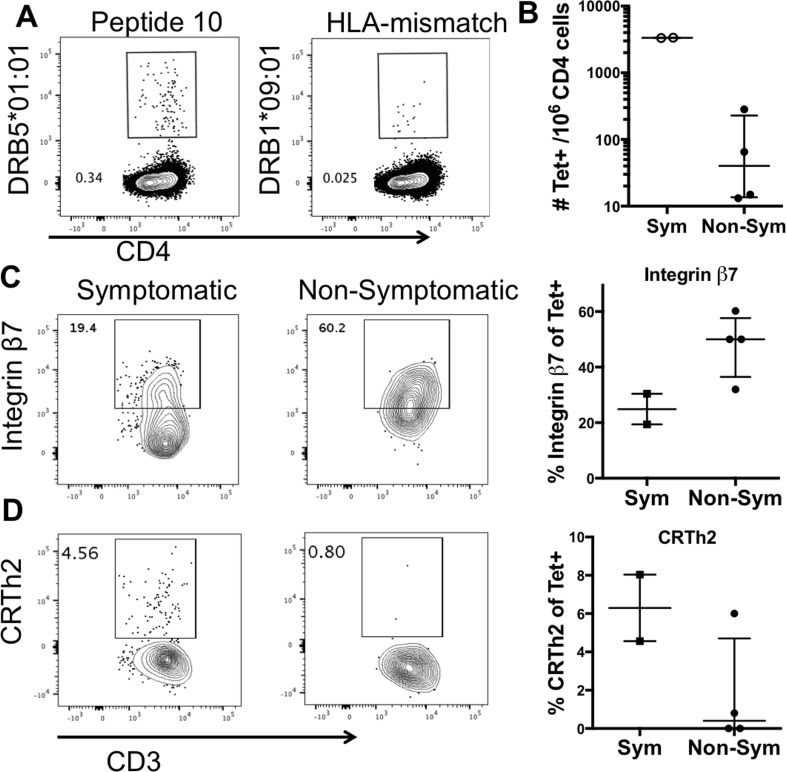
Tetramer staining and phenotypic surface marker expression of T cells in peanut-sensitized donors after in vitro culture.A) a representative plot showing staining with tetramer and HLA-mismatch control. B) Quantification of tetramer-positive cells in peanut-sensitized, symptomatic (Sym) (n = 2) or non-symptomatic (Non-Sym) (n = 2) donors. In the non-symptomatic cohort, donors were tested with multiple tetramers, therefore a total of 4 data points are shown in this cohort. Median with interquartile range is shown. C) Integrin β7 expression and D) CRTh2 expression in tetramer positive cells from peanut-sensitized, symptomatic and non-symptomatic patients. Left panels show representative FACS plots. Right panels show graphs quantifying Integrin β7 and CRTh2 expression in tetramer+ cells from all samples tested. No statistical analysis was performed due to low sample size.